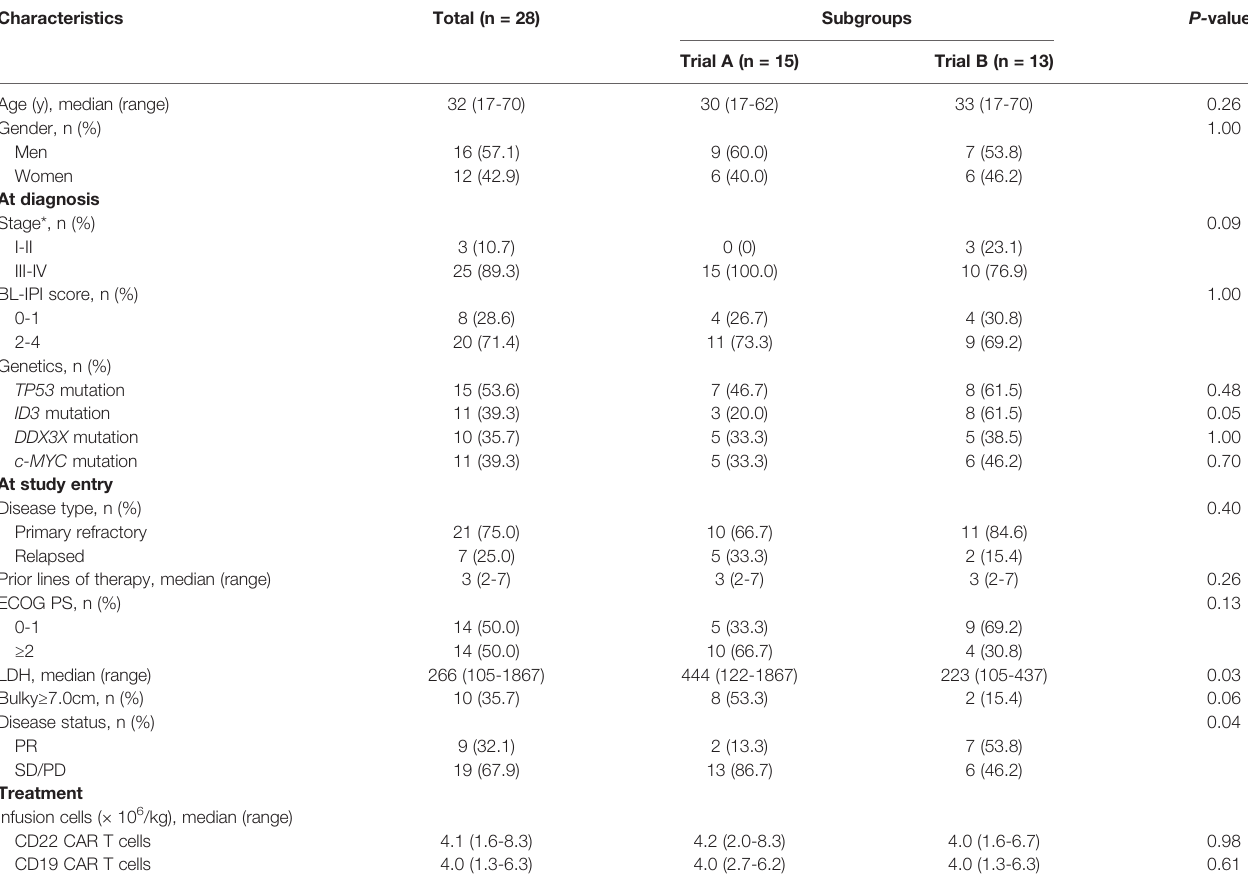
TABLE 1 | The baseline and treatment characteristics of the adult patients with relapsed/refractory Burkitt lymphoma enrolled in our study. Characteristics Total (n =